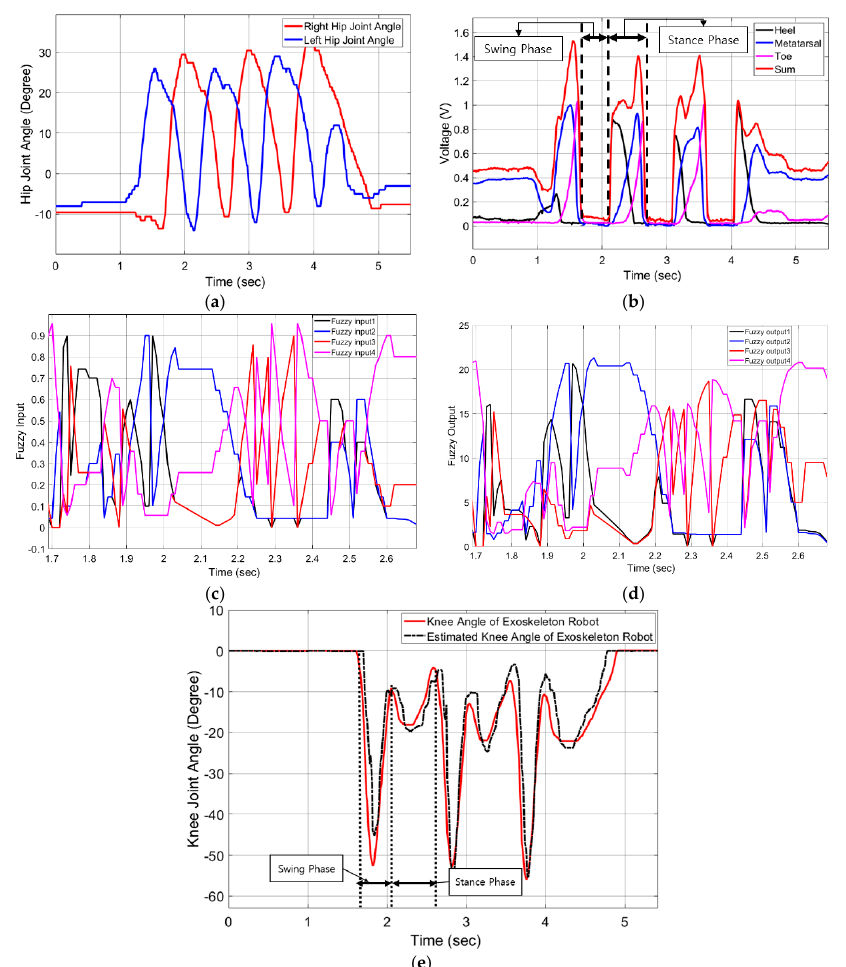
Figure 10. Experimental results of the proposed algorithm for estimating the knee joint angle: ( a ) the crisp inputs of the hip joint angles, ( b ) the plantar pressure sensors for distinguishing the gait phase, ( c , d ) the fuzzy inputs and outputs, respectively, between 1.7 and 2.7 s, and ( e ) the results of the knee joint angle x r and the estimated knee joint angle ˆ x r